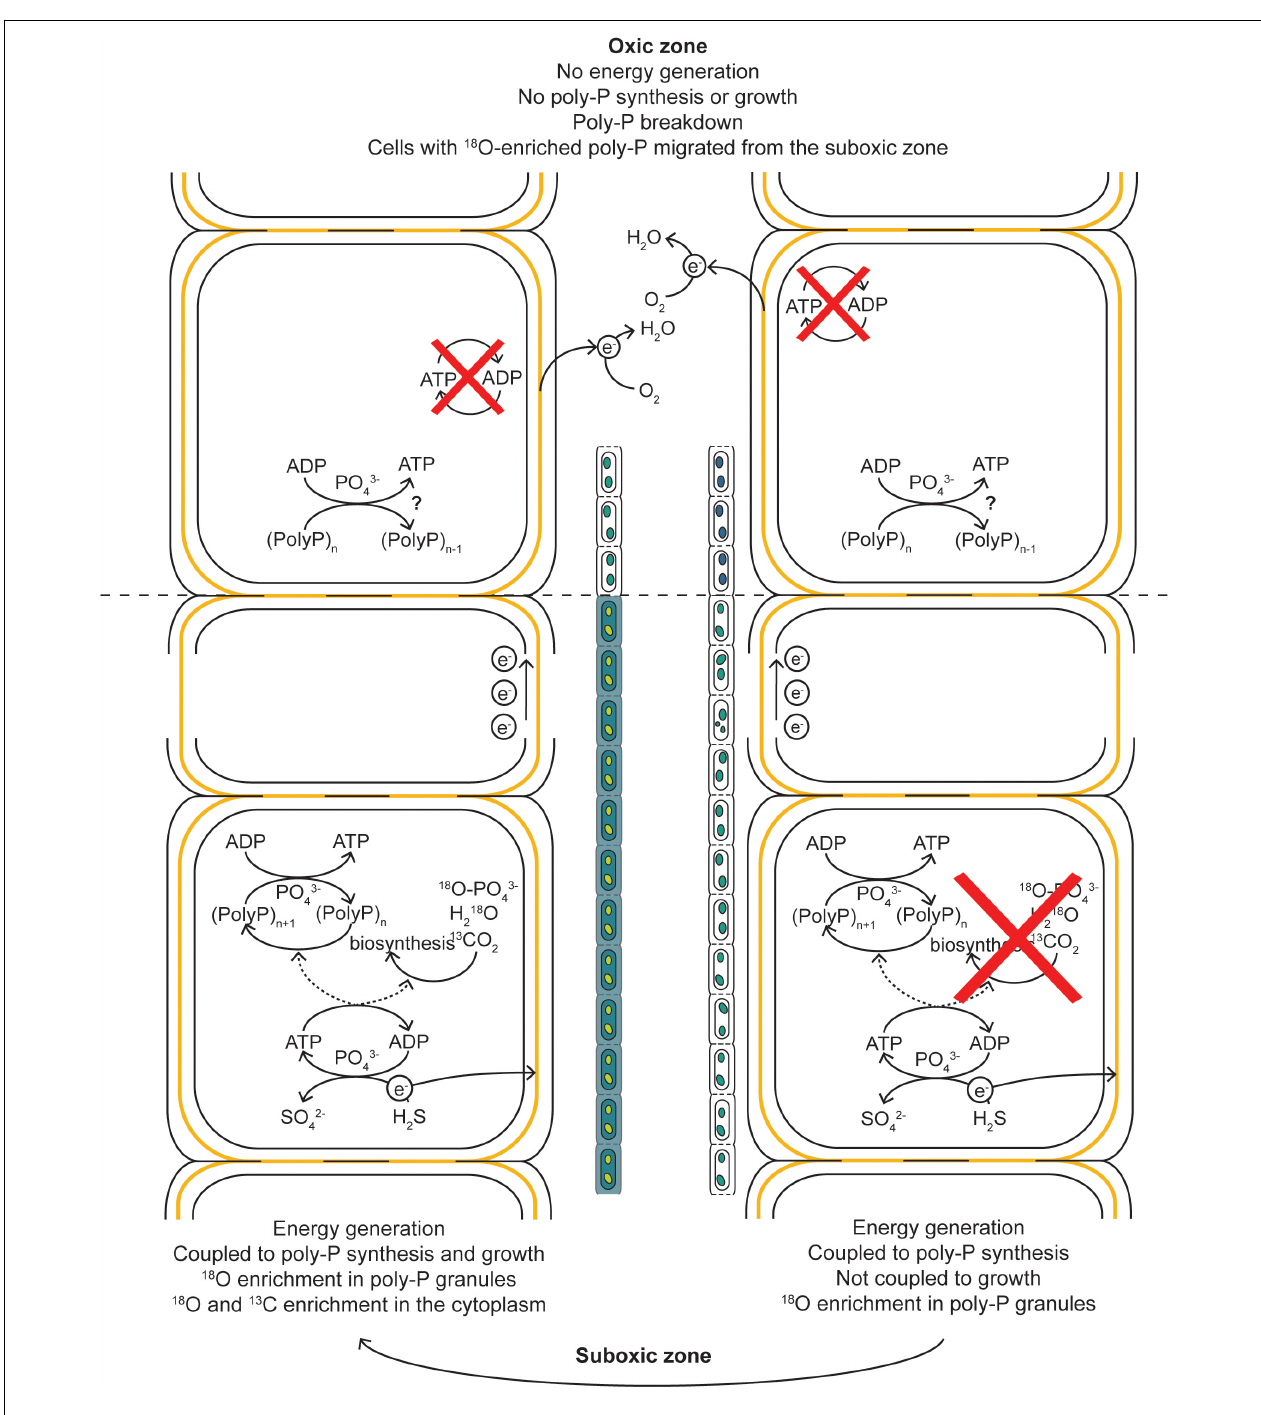
FIGURE 7 | Schematic diagram of our hypothesis explaining the observed 13 C and 18 O labeling patterns in cable bacteria. When a filament has access to O 2 , the cells performing the sulfide-oxidizing half-reaction can generate energy in the form of ATP. During a period of growth arrest, this energy is not directed toward biosynthesis and growth but toward the build-up of poly-P granules, resulting in an 18 O enrichment of the poly-P granules but no 13 C and 18 O enrichment of the cytoplasm. During a period of growth, the energy is directed toward both growth and poly-P synthesis, resulting in a 13 C and 18 O enrichment of the cytoplasm and 18 O enrichment of the poly-P granules. The electrons generated via the sulfide-oxidizing half-reactions are transported toward the cells in the oxic zone via the electron-conducting fibers in the shared periplasm of a filament. Within the oxic zone, the electrons are used to reduce O 2 , but this process does not lead to energy generation and thus cannot lead to an 18 O enrichment in the poly-P granules. That such enrichment is observed in cells from the oxic zone is explained by migration of the cells from the suboxic into the oxic zone during the incubation. Before this migration, the cells entered a non-growing stage of the cell cycle and “prepared” for a survival in the oxic zone. Part of this preparation included the build-up of poly-P granules. Within the oxic zone, the poly-P can be broken down.